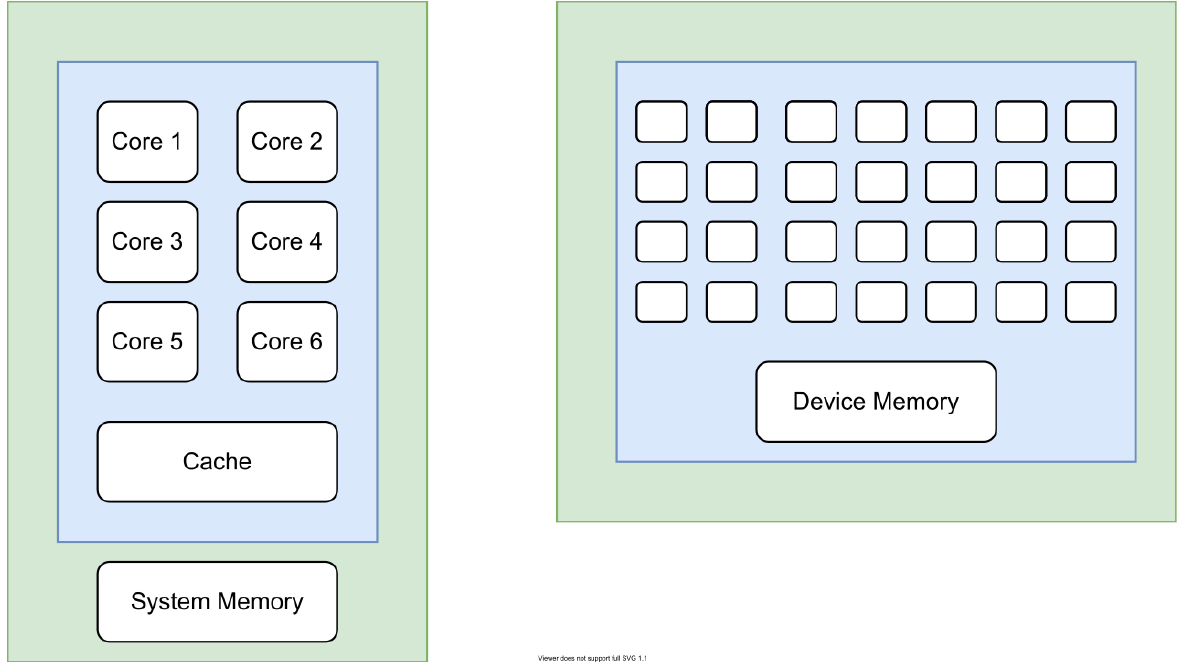
Figure 3. Difference between CPU and GPU in terms of number of cores. (a) CPU with multicolors and (b) GPU with hundreds of